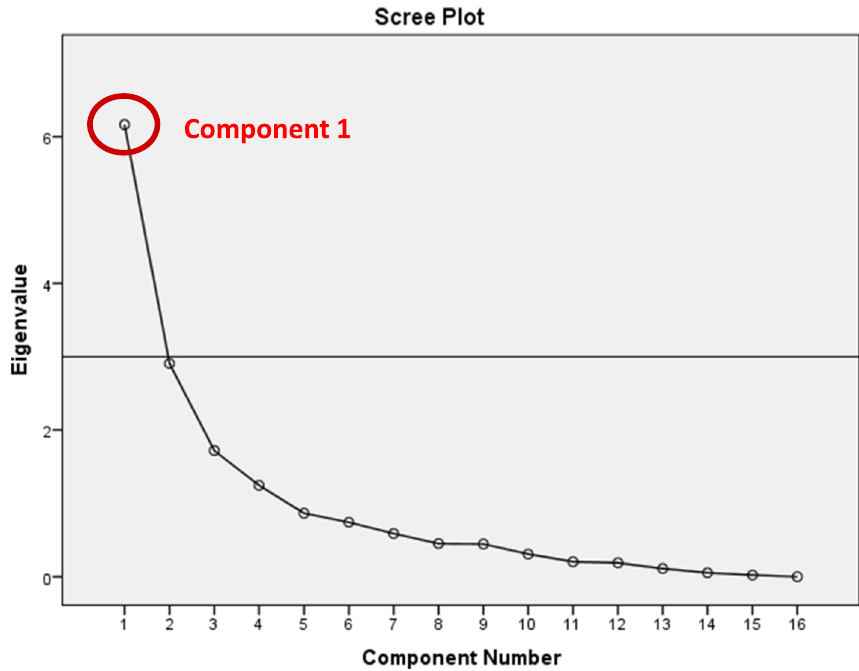
Fig. 6 Scree plot for the second runs